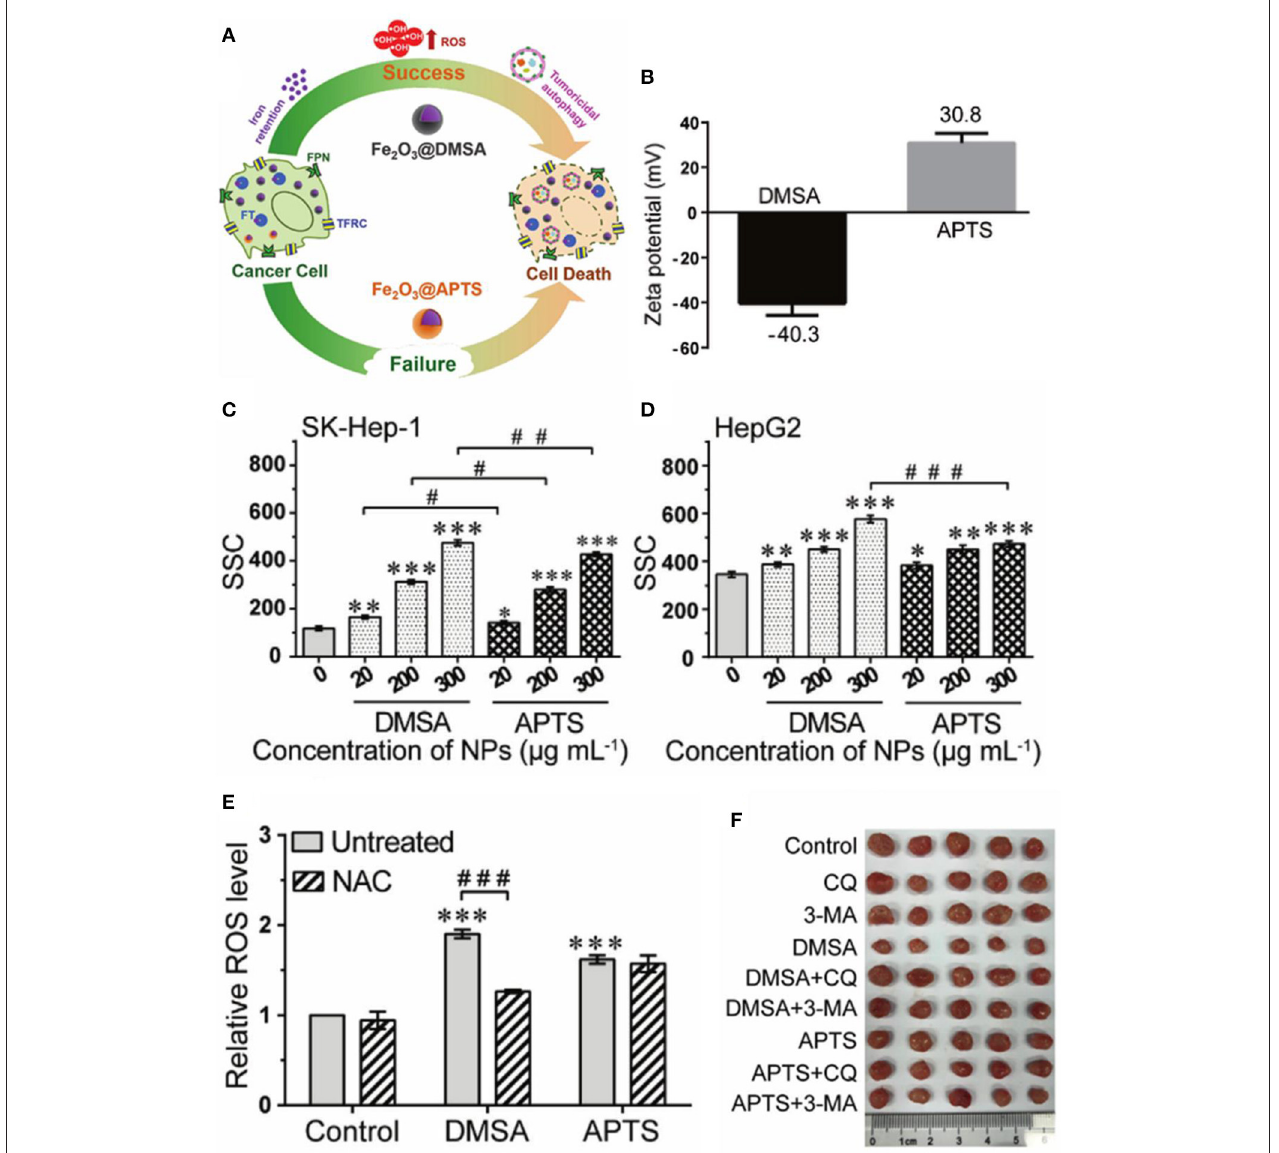
FIGURE 4 | (A) Schematic illustration for Fe 2 O 3 @DMSA promoted ROS-induced tumoricidal autophagy. (B) Zeta potential of Fe 2 O 3 @DMSA and Fe 2 O 3 @APTS. (C,D) Cellular uptake of Fe 2 O 3 @DMSA and Fe 2 O 3 @APTS. (E) ROS production of SK-Hep-1 cells exposed to Fe 2 O 3 @DMSA or Fe 2 O 3 @APTS. (F) Photographs of tumors. Statistical significance, * p < 0.05,** p < 0.01, and *** p < 0.001 compared with control. # p < 0.05, ## p < 0.01, and ### p < 0.001 between the indicated groups. Reproduced, with permission, from Xie et al. (2020). Copyright 2020, WILEY-VCH Verlag GmbH & Co. KGaA,